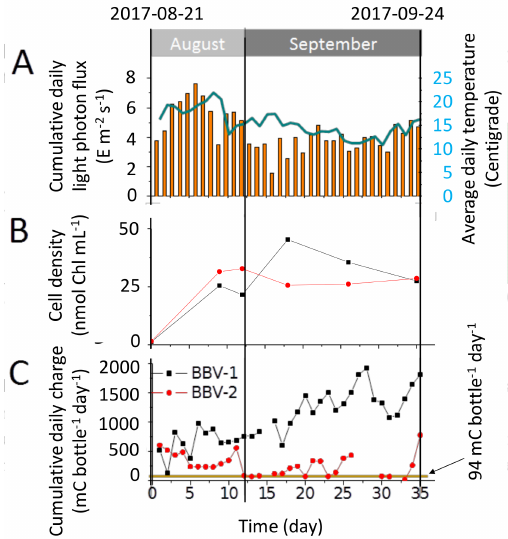
Figure 4. Performance of the BBV systems during the entire experimental run of 35 days ( A ) Cumulative daily light photon flux (yellow bars) falling on the BBV systems and average daily temperature (blue line). ( B ) Growth curve over 35 days for the cells of Chlorella sorokiniana inoculated into the BBV systems. ( C ) Daily charge accumulation by the BBV systems inoculated with C. sorokiniana over 35 days. The yellow dotted line shows the average abiotic charge accumulation per day for a BBV system operated with medium